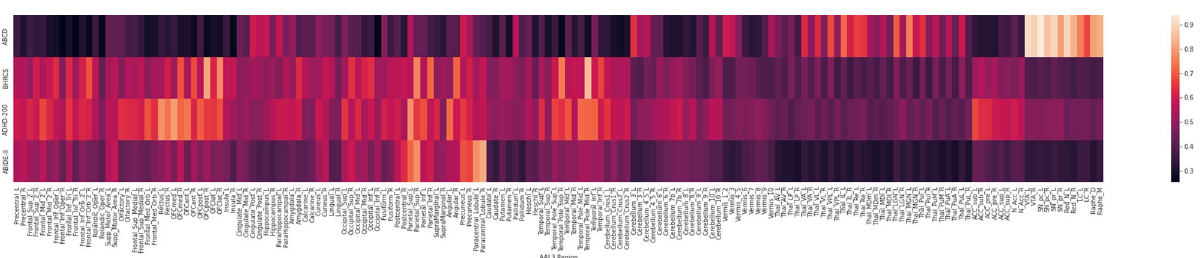
Figure 3. Heat map of importance for age models within each dataset. Lighter areas indicate more representative brain regions. The datasets and ROIs are in the y- and x-axis, respectively. The ROIs follow the AAL3 atlas acronyms 41